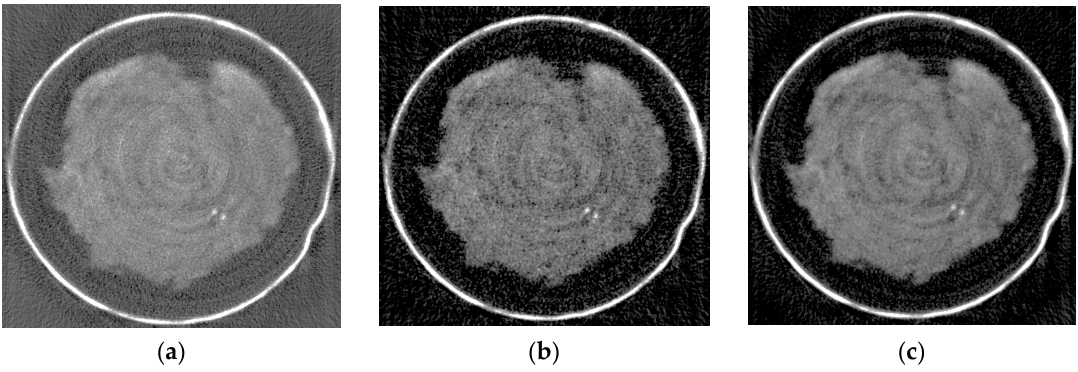
Figure 3. The examples of the tomography slices of the golden vial reconstructed by the conventional FBP algorithm ( a ), by the SIRT reconstruction with 150 iterations ( b ), by the SART algorithm with 150 iterations ( c ).